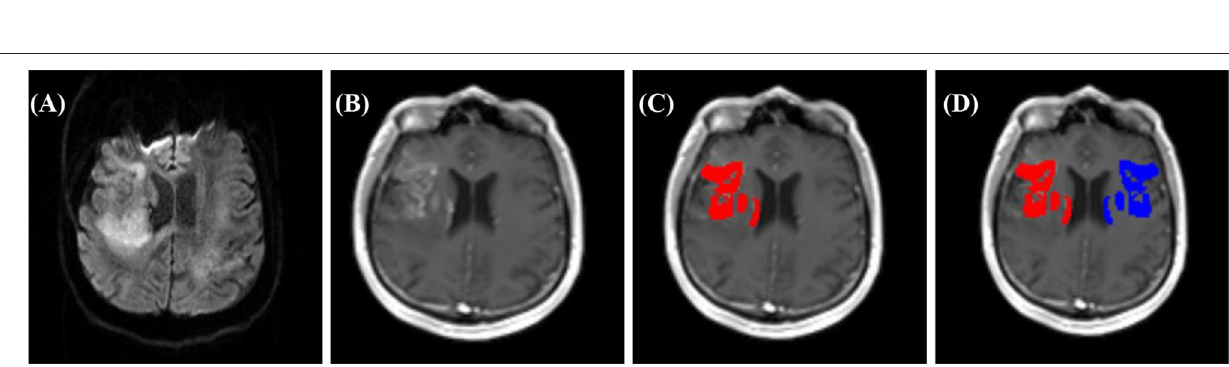
FIGURE 2 | Example of BBBP assessment in a patient with subacute right middle cerebral artery infarction. (A) DWI b1000 for the detection of the infarcted area, (B–D) T1 post-CA sequence: (B) with contrast-agent enhancement (CE), (C) delineation of CE within ischemic lesion (CE-ROI red), with (D) corresponding mirrored ROI